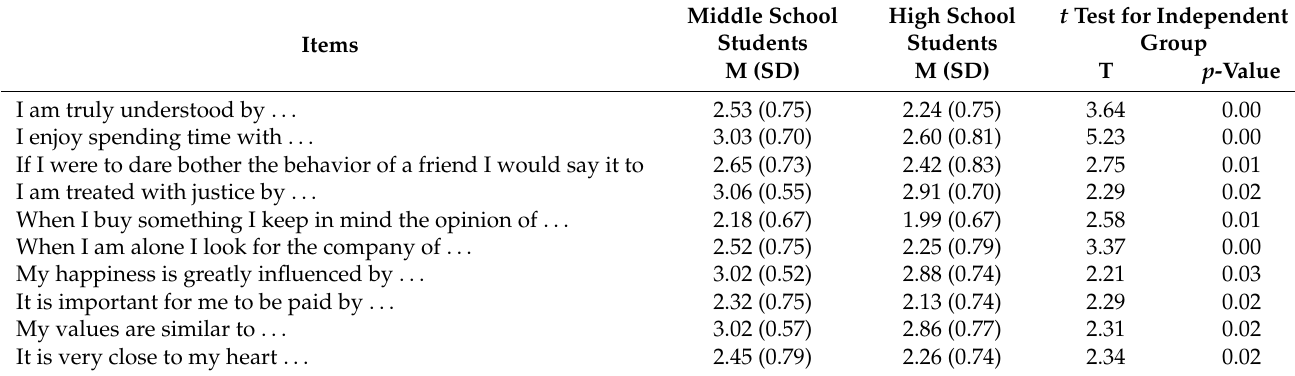
Table 8. The Independent Samples t Test: significant items of Teacher Relationship Scale.